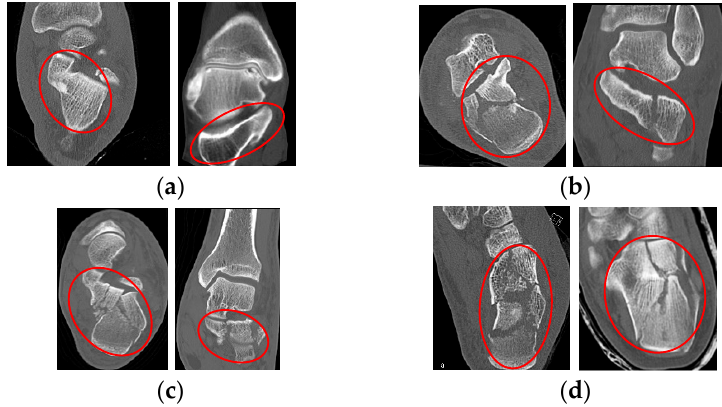
Figure 1. The Sanders system of fracture classification on the calcaneus [1,2,20]: ( a ) Normal calcaneus